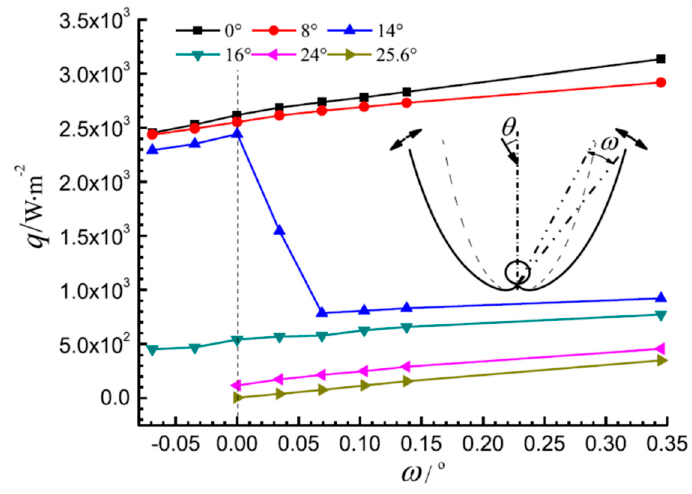
Figure 8. The average heat flux density on the absorber with rotation of the CPC reflector ( C = 4, Ct = 0.5) [31].